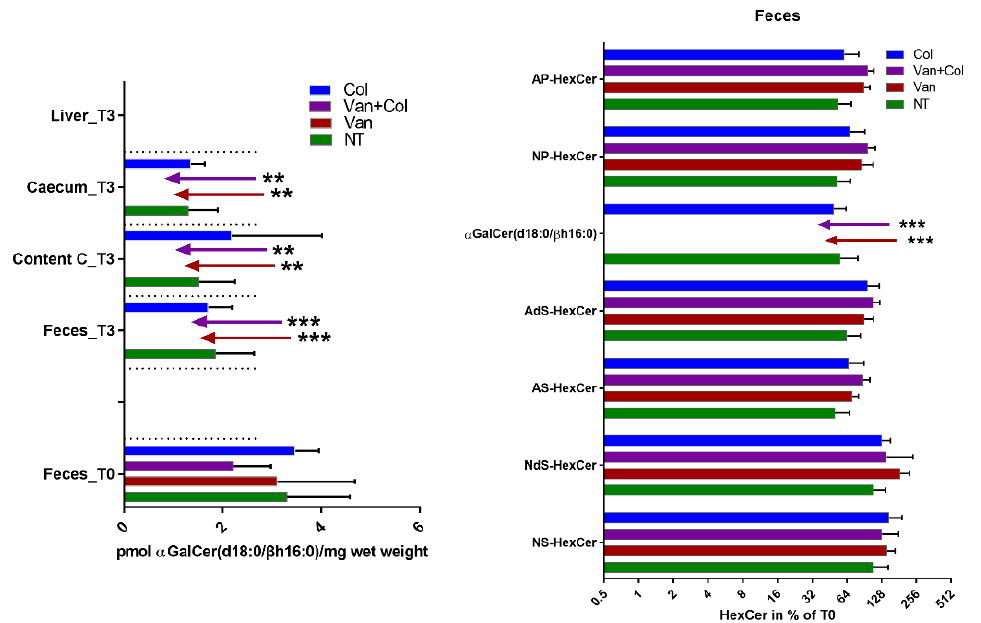
Figure 2. Treatment of mice with the antibiotic vancomycin (Van) led to loss of α -GalCer in feces and intestine of mice. Mice were treated for 3 weeks with vancomycin (Van), colistin (Col), with both antibiotics (1 g/L), or were not treated (NT). Feces were collected before starting treatment (T0), and after 3 weeks of treatment (T3), together with caecum, content of caecum (Content C) and content of liver were analyzed for the presence of α -GalCer and host β -GalCer and β -GlcCer (summarized as HexCer) with various ceramide anchors (A: alpha-hydroxy acyl chain, N: non-hydroxy acyl chain, P: phytosphingosine, S: sphingosine, dS: dihydrosphingosine). Samples from 4 to 5 mice were analyzed per group, and the mean ± standard deviation is plotted. **: p < 0.01, ***: p < 0.001 compared to corresponding controls (NT).